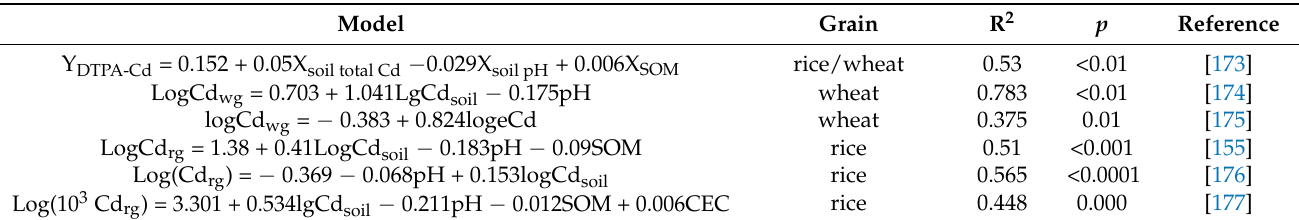
Table 2. The prediction model for Cd content in rice or wheat grains. Model